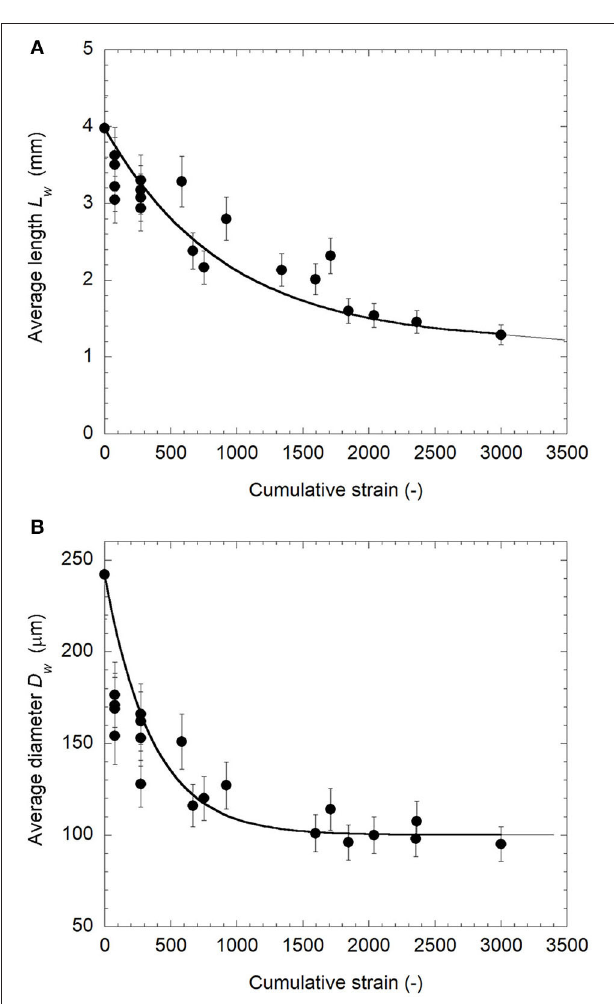
FIGURE 2 | Changes in length (A) and diameter (B) of 4mm flax fibers as a function of cumulative strain. Symbols are experimental points, the lines are fits using (Equations 1, 2). Reprinted from Berzin et al. (2017) with permission.